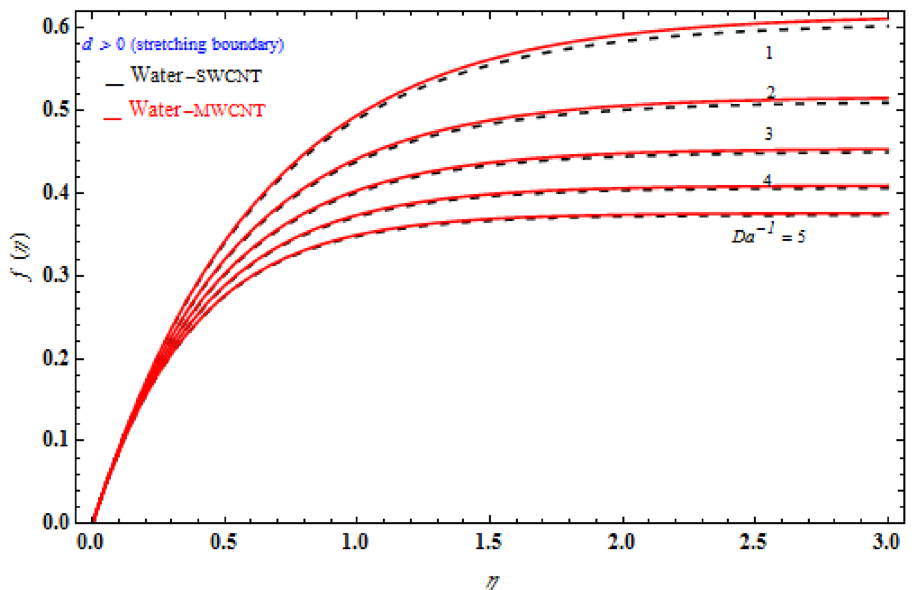
Figure 4. Influence of inverse Da -1 on f (η) with k 1 = 1, M = 1, τ = 90° for stretching case.